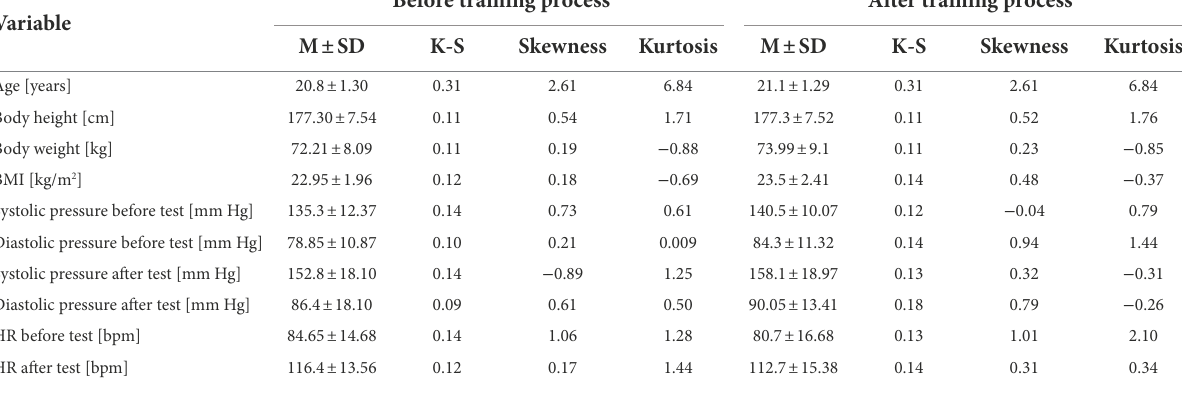
TABLE 1 Elements of normal distribution in somatic and hemodynamic data before and after the training process in cadets pilots ( n = 20).